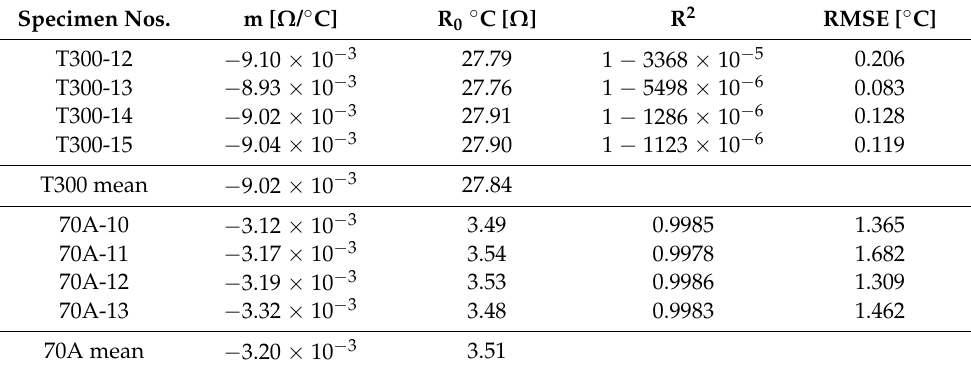
Table 4. The calculated values of the linear fit, and also the R2 and RMSE values. Specimen